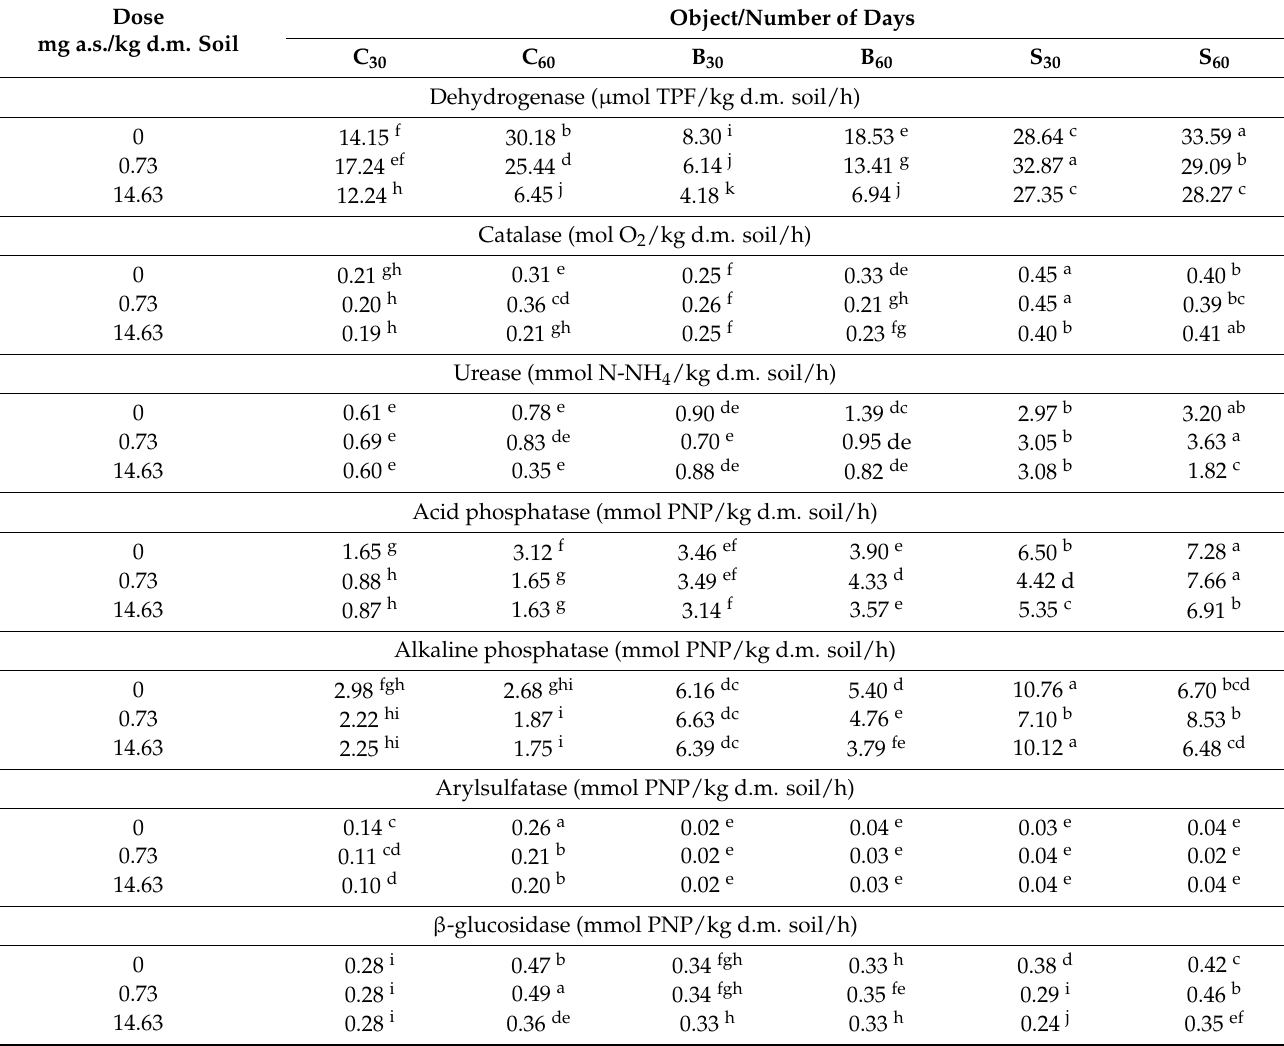
Table 3. Enzymatic activity in soil contaminated with Successor T 550 SE.